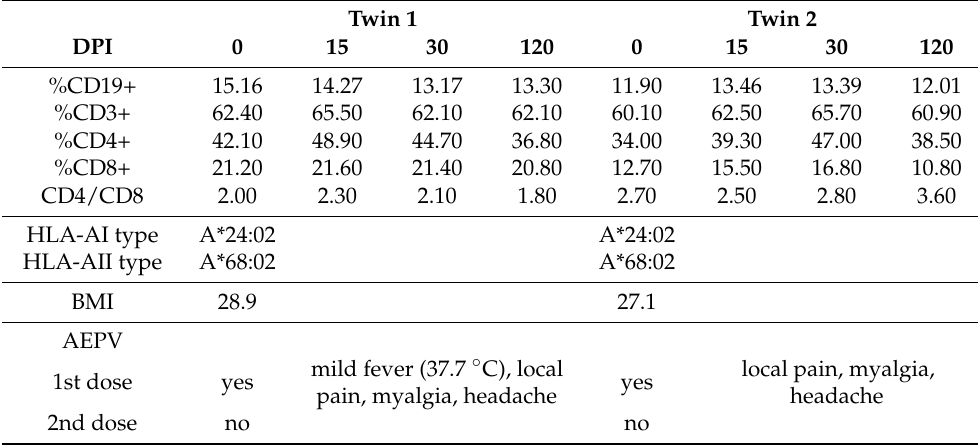
Table 1. Absolute frequency of B and T lymphocytes and clinical information of the